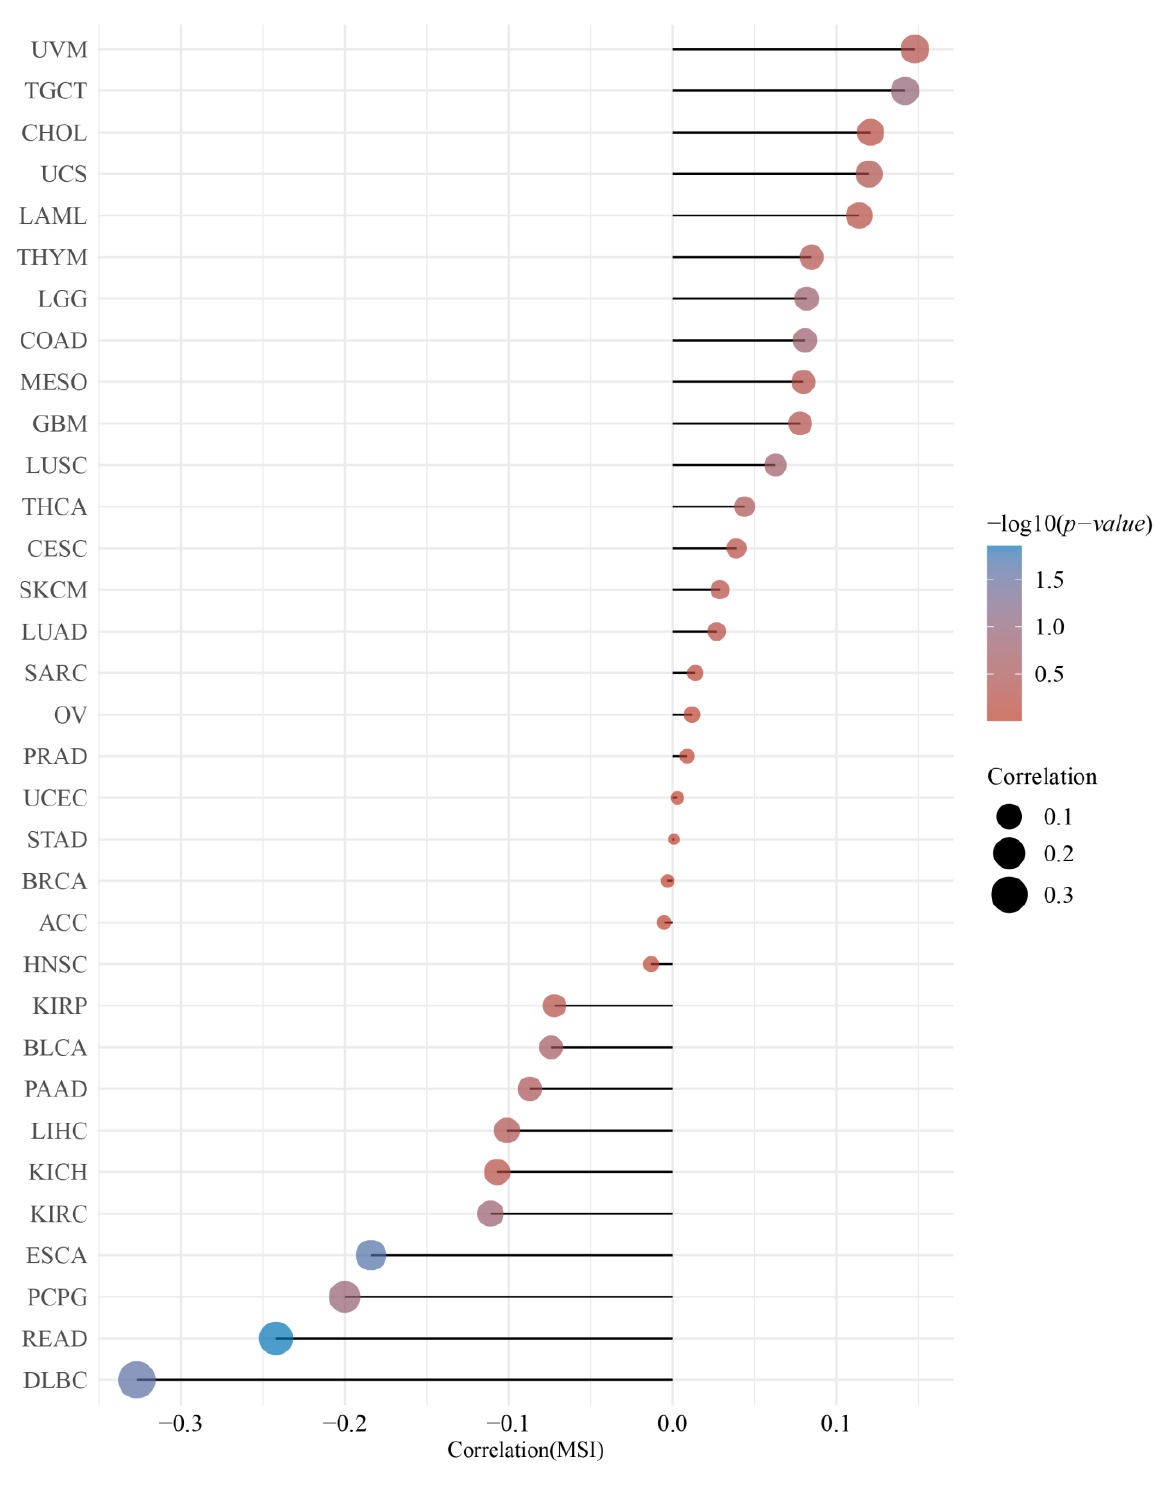
Figure 4. Correlation between the DMRT3 expression and microsatellite instability (MSI) in pan- cancer tumors (Spearman analysis). The horizontal coordinates represent the correlation coefficients between the DMRT3 gene and the MSI, the vertical coordinates are different tumors, the size of the dots in the figure represents the correlation coefficients, and the color of the dots represents the significance of the p -value, with blue representing a smaller p -value.